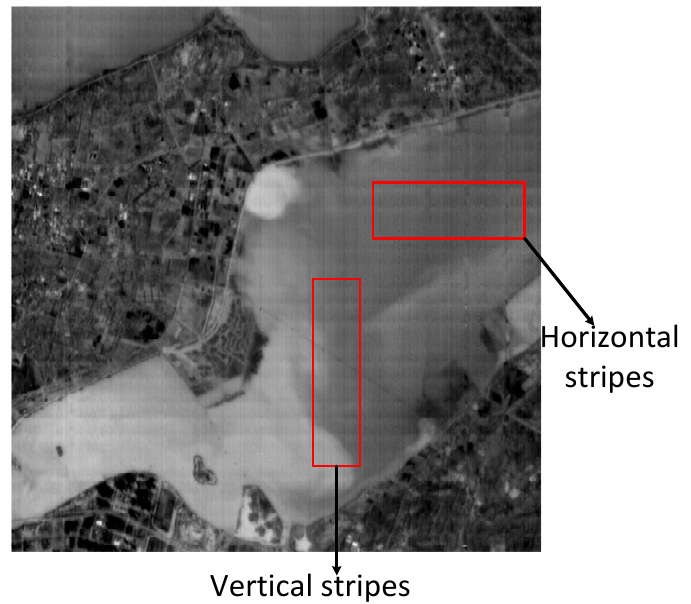
Figure 1. Original image from SDGSAT ‐ 1 (512 * 512).